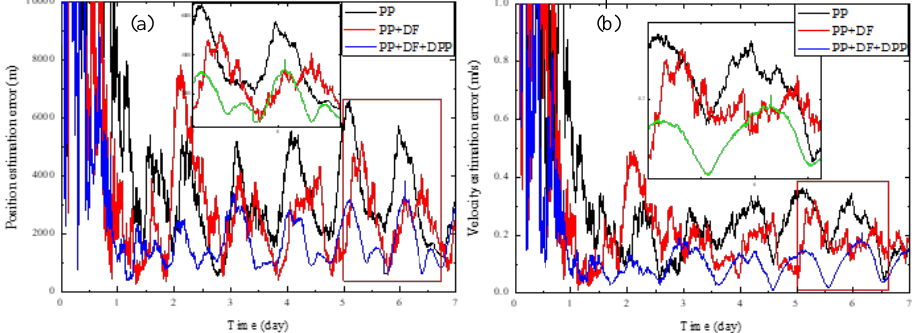
Figure 4. Performance comparison of different navigation measurements with systematic biases. ( a ) Position estimation error; ( b ) Velocity estimation error. Table 4. Steady-state position and velocity estimation errors with di ff erent navigation measurements.